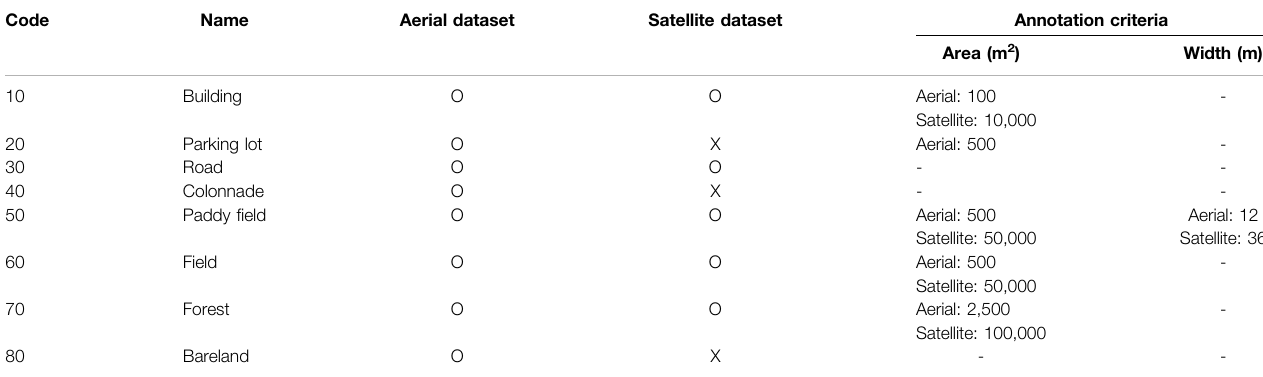
TABLE 2 | Difference between classi fi cation catagories of aerial image and satellite image.